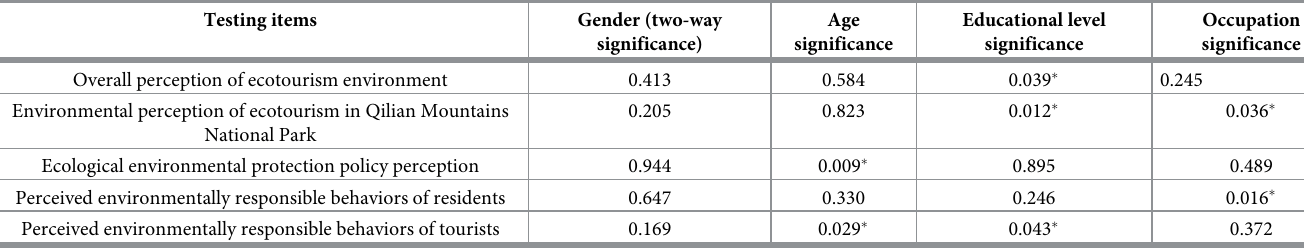
Table 8. The test results of significant differences in resident questionnaire.